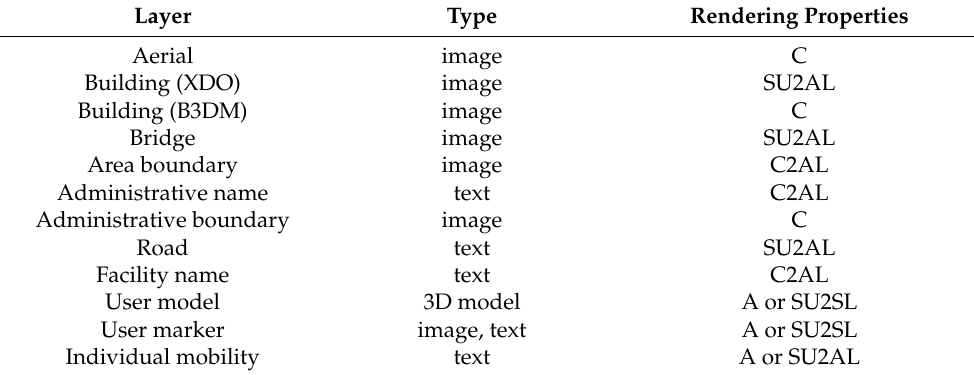
Table 6. Rendering properties according to data layer.